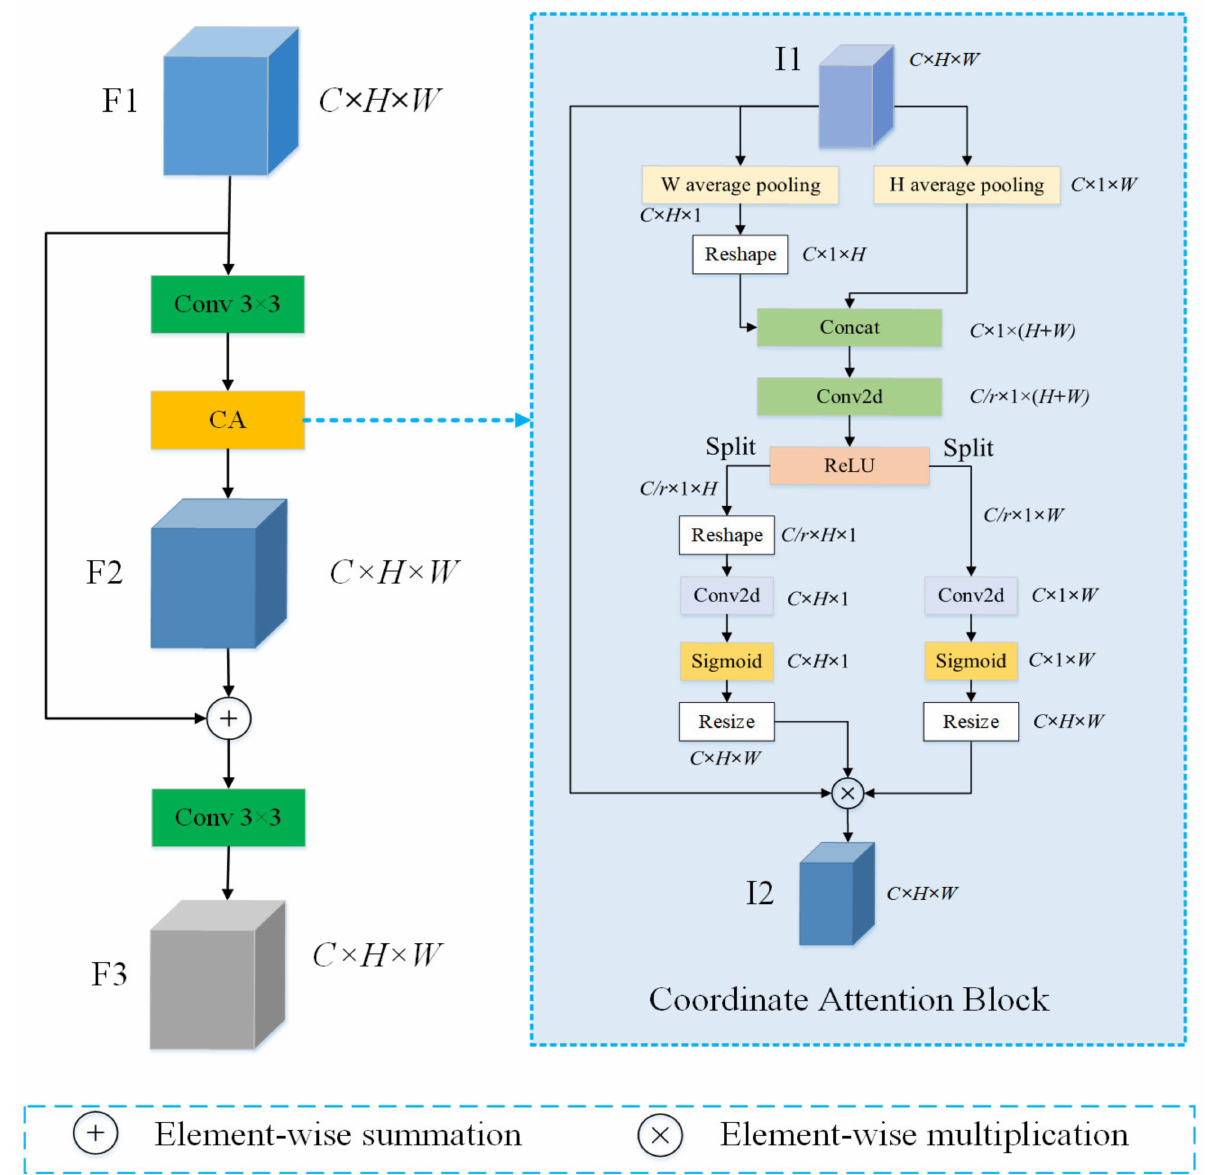
Figure 2. Feature Enhancement Module (FEM). “ W average pooling” and “ H average pooling” refer to 1D horizontal global average pooling and 1D vertical global average pooling, respectively. The r indicates the reduction ratio, where r is set to 16. The Reshape operation permutes the Dimension of the tensor. The Resize operation extends the tensor to the same size as the input